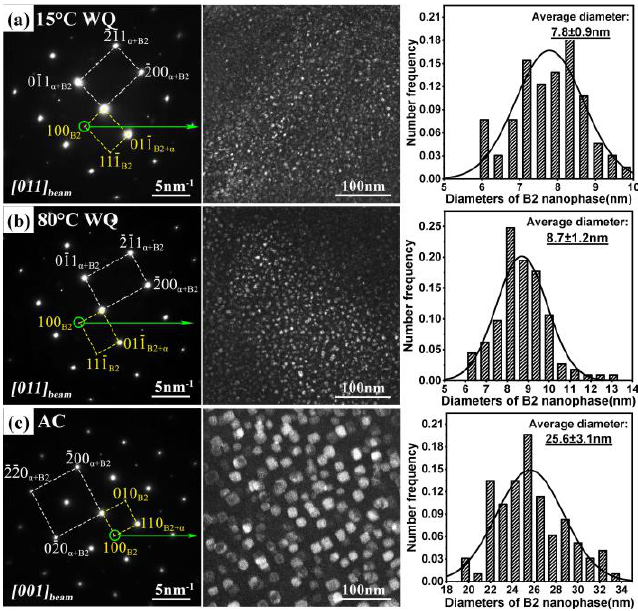
Figure 2. Electron diffraction patterns, dark field images corresponding to the {100} B2 spot, as well as the size distribution of B2 nano-particles for the solution-treated 6Ni2Mo alloy followed by 15 °C WQ ( a ), 80 °C WQ ( b ) or AC ( c ).